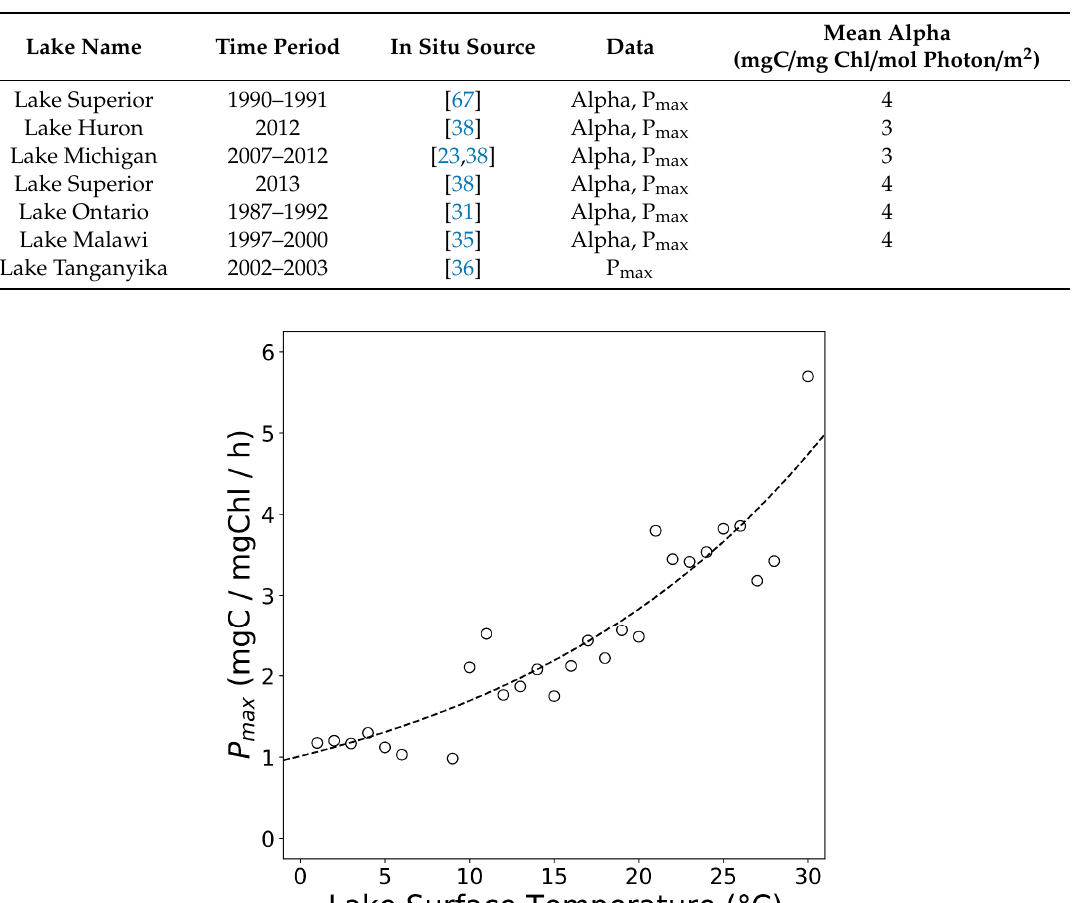
Table 3. Sources for historic alpha and P max data. The mean alpha value from each study is also included, rounded to the nearest integer.